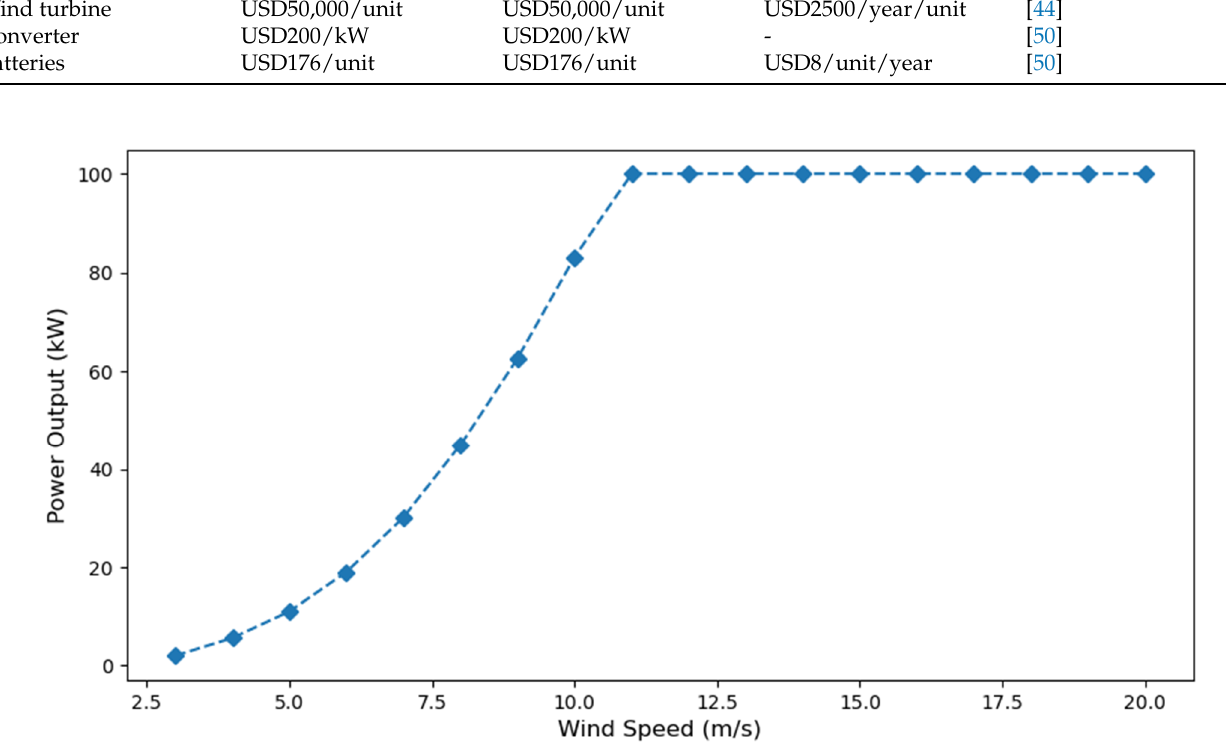
Figure 5. The WT power curve.